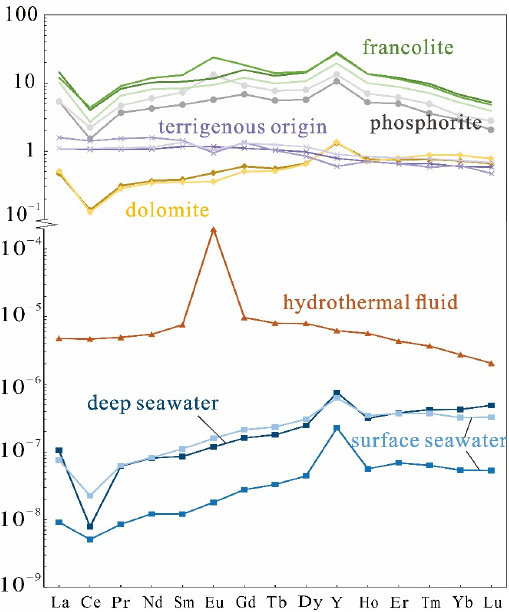
Figure 8. PAAS–normalized rare earth element distributions of different systems and samples. Data are based on reported REY, including high-temperature hydrothermal fluid [63], modern seawater from Indian Ocean and South Pacific Ocean [45,47] and terrigenous components [64] Data of phosphorites and francolite and dolomite grains are from the LFC section, Zhijin deposit.